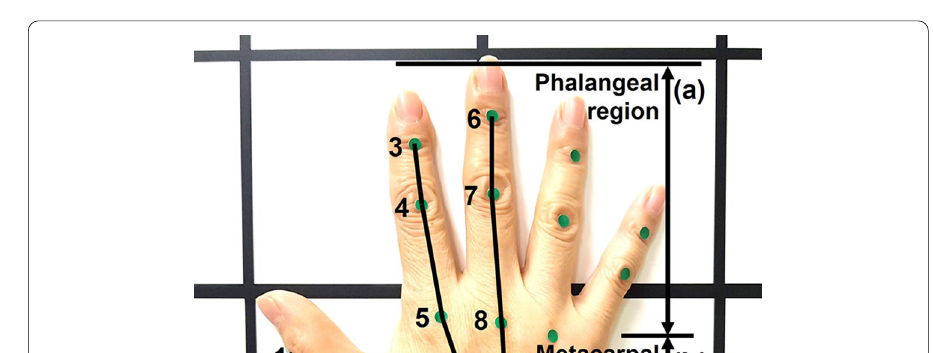
were right-handed, and those with any hand injuries or abnormalities were excluded.